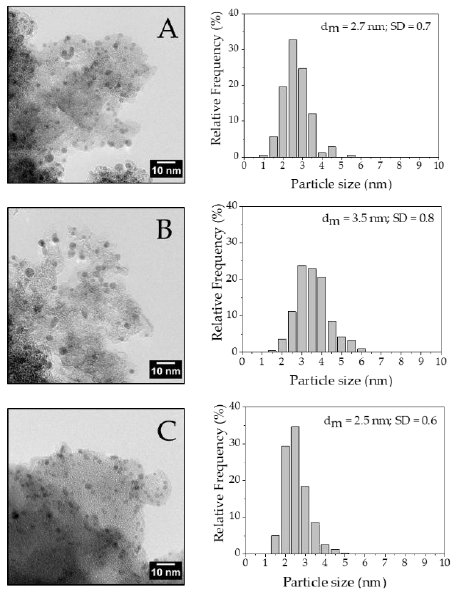
Figure 2. TEM of ( A ) Pd/Norit_0.65, ( B ) Pd/G60_0.65 and ( C ) Pd/KB_0.65. Nanomaterials 2020 , 10 , x FOR PEER REVIEW Hydrogenation reaction was performed both on Na-Muc and t,t-MA at 50 °C and 1 bar of hydrogen for a period of 90 min.